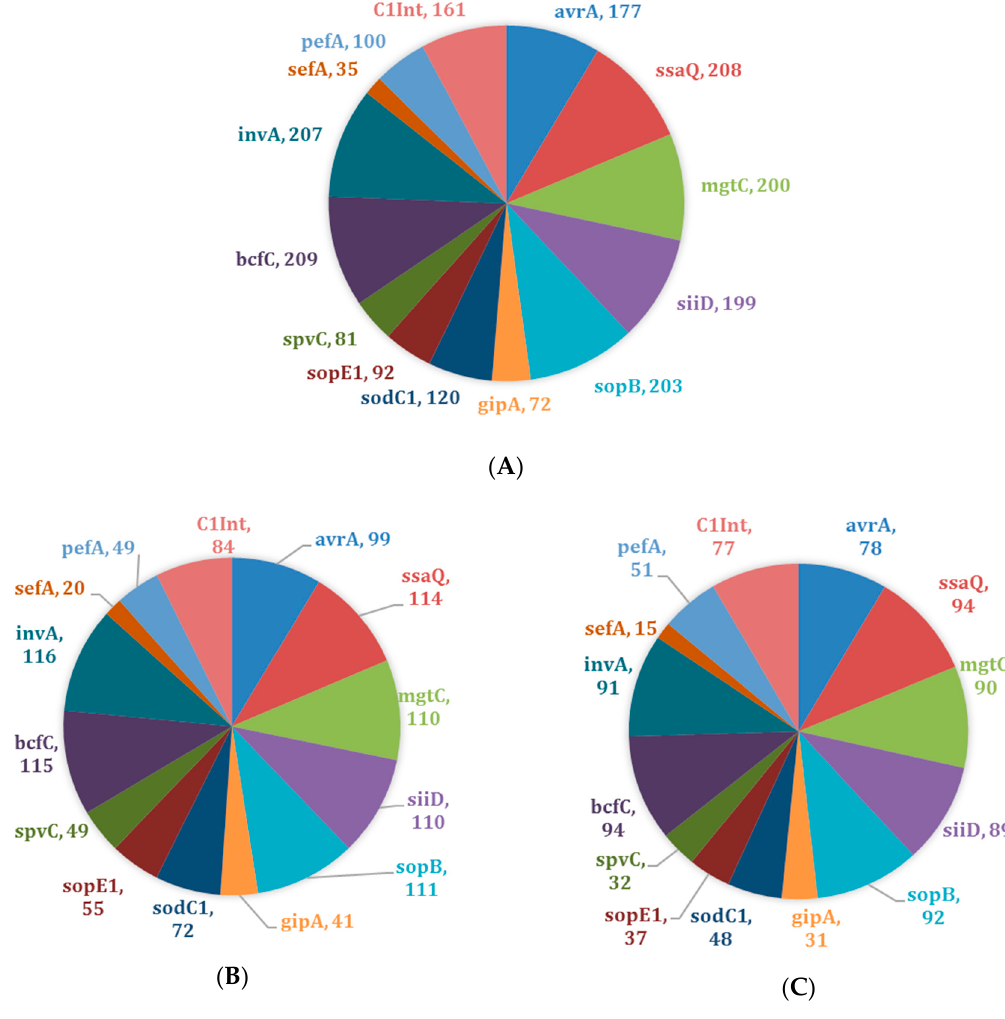
Figure 1. Distribution of virulence genes across Salmonella isolates ( n = 211). ( A ) Prevalence of virulence genes across all Salmonella isolates; ( B ) Prevalence of virulence genes across drug-resistant Salmonella isolates only ( n = 117); ( C ) Prevalence of virulence genes across drug-susceptible Salmonella isolates only ( n = 94).